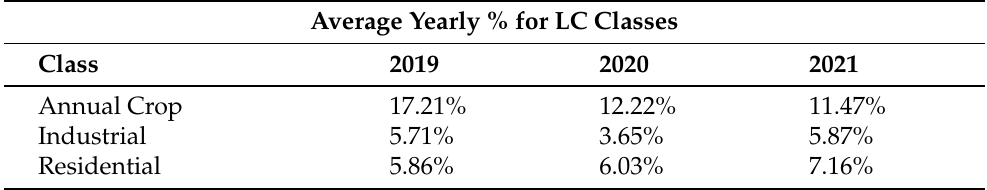
Table 5. Trends of relevant LC classes for 2019–2021 for the CER